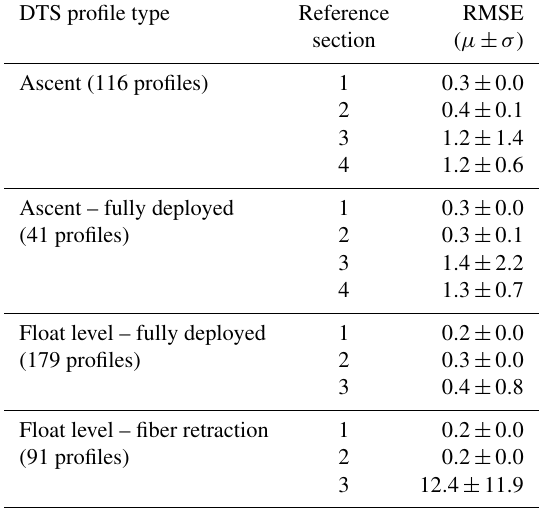
Table 1. The average and standard deviation of the RMSE of the FLOATS DTS reference section temperature compared to the refer- ence temperature sensors for the ascent and float-level